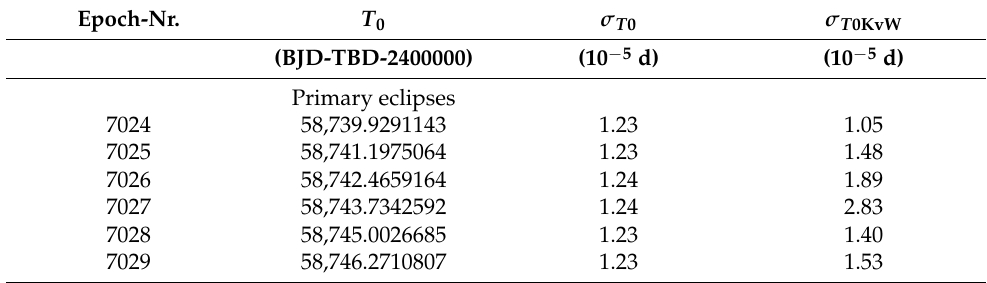
Table A1. Similar to Table 1, but using the KvW method with three folds.